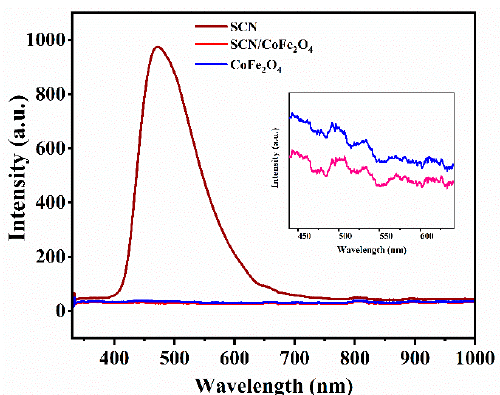
Figure 4. Photoluminescence spectra of SCN, CoFe 2 O 4 and SCN / CoFe 2 O 4 nanocomposite.